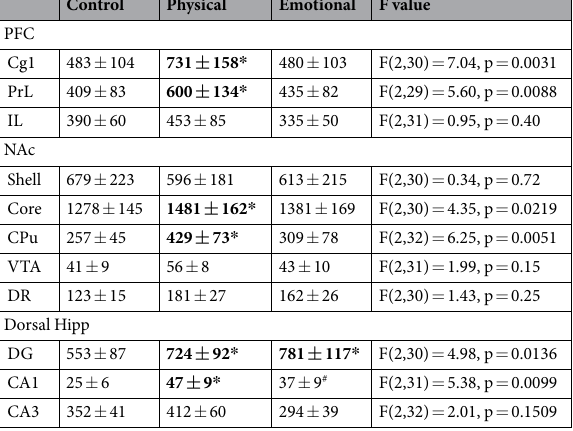
Δ FosB induction in the